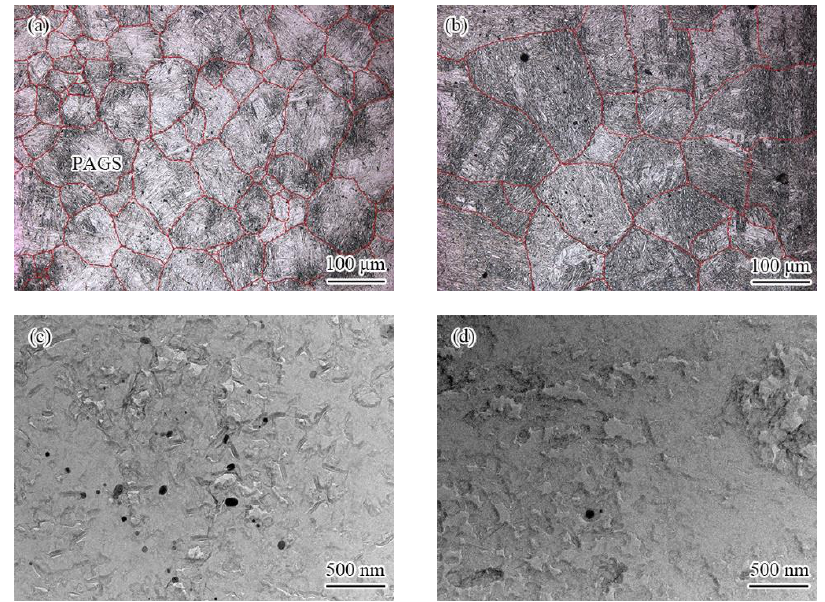
Figure 1. Thermal simulation experiment process of ( a ) Nb-1, ( b ) Nb-2, ( c ) Nb-3. The tested steel was first heated to 1100 °C and 1200 °C, respectively, and held for 300 s, and then quenched to room temperature to observe the prior austenite grains and undissolved phases, as shown in Figure 2a – d.